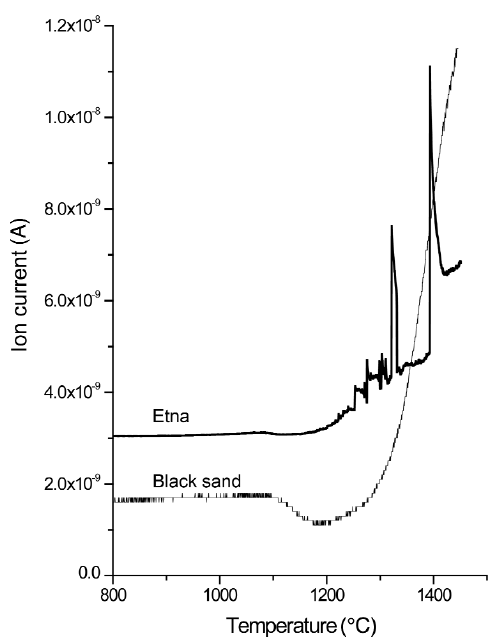
Fig. 14. Comparison of the oxygen release from Ocean Island basalt (Hawaii) and Island Arc basalt (Etna -